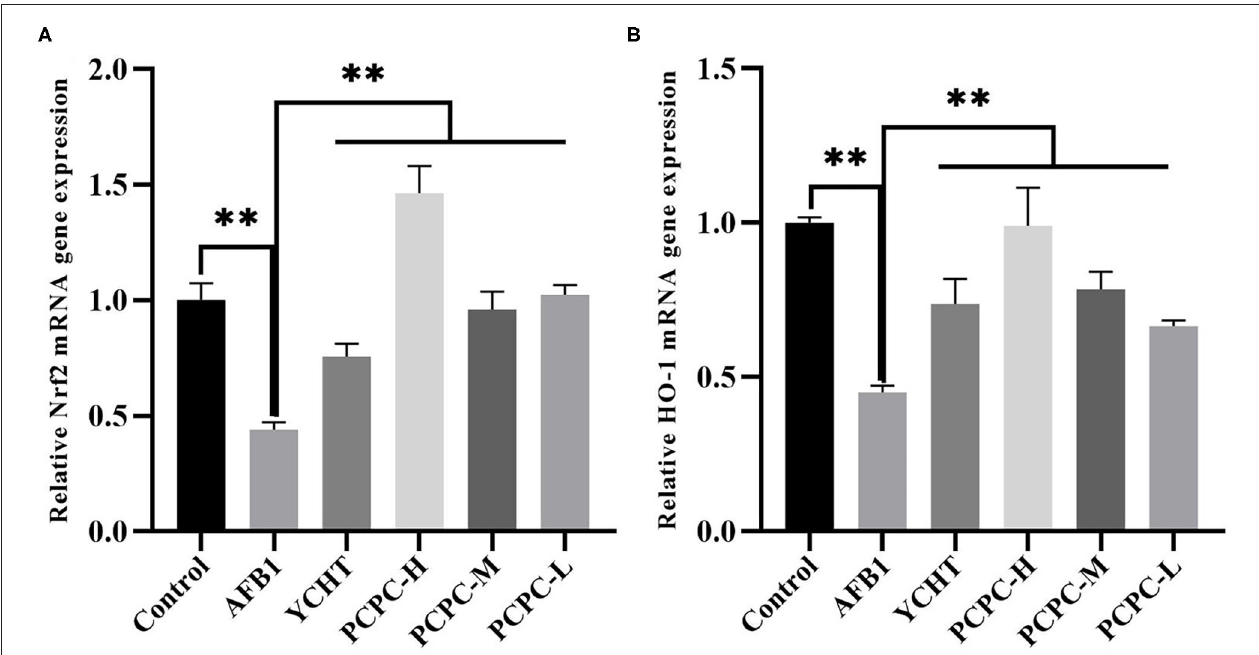
FIGURE 5 | Effect of PCPC on expression levels of Nrf2 and HO-1 in kidney of broilers. The mRNA expression of Nrf2 and HO-1 was identified by quantitative real-time PCR. All data are expressed as means ± SD. (A) Nrf2 expression; (B) HO-1 expression. Asterisk indicates significant difference (p < 0.05) compared to the control group and AFB1